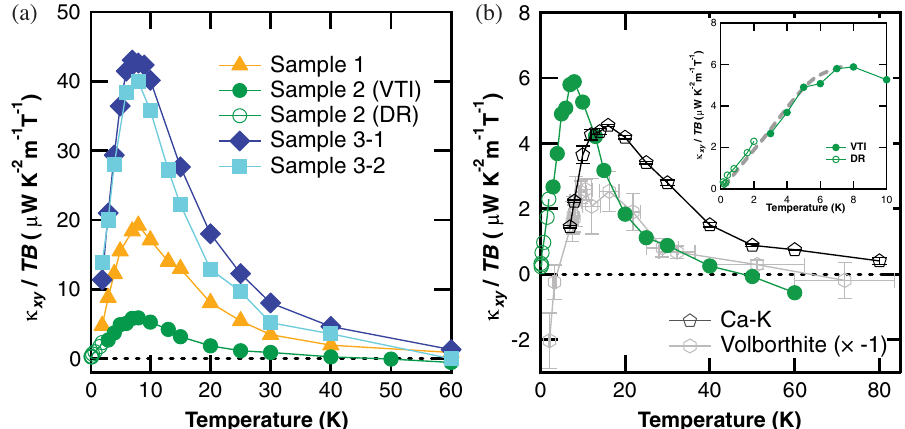
=TB . (a) Comparison of κ =TB of three Cd-K samples. The filled (open) symbols represent xy xy =TB of Cd-K sample 2 (green circles), xy =TB of volborthite is multiplied by − 1 . The xy =TB of sample 2. The dashed line is a guide to the eye. xy